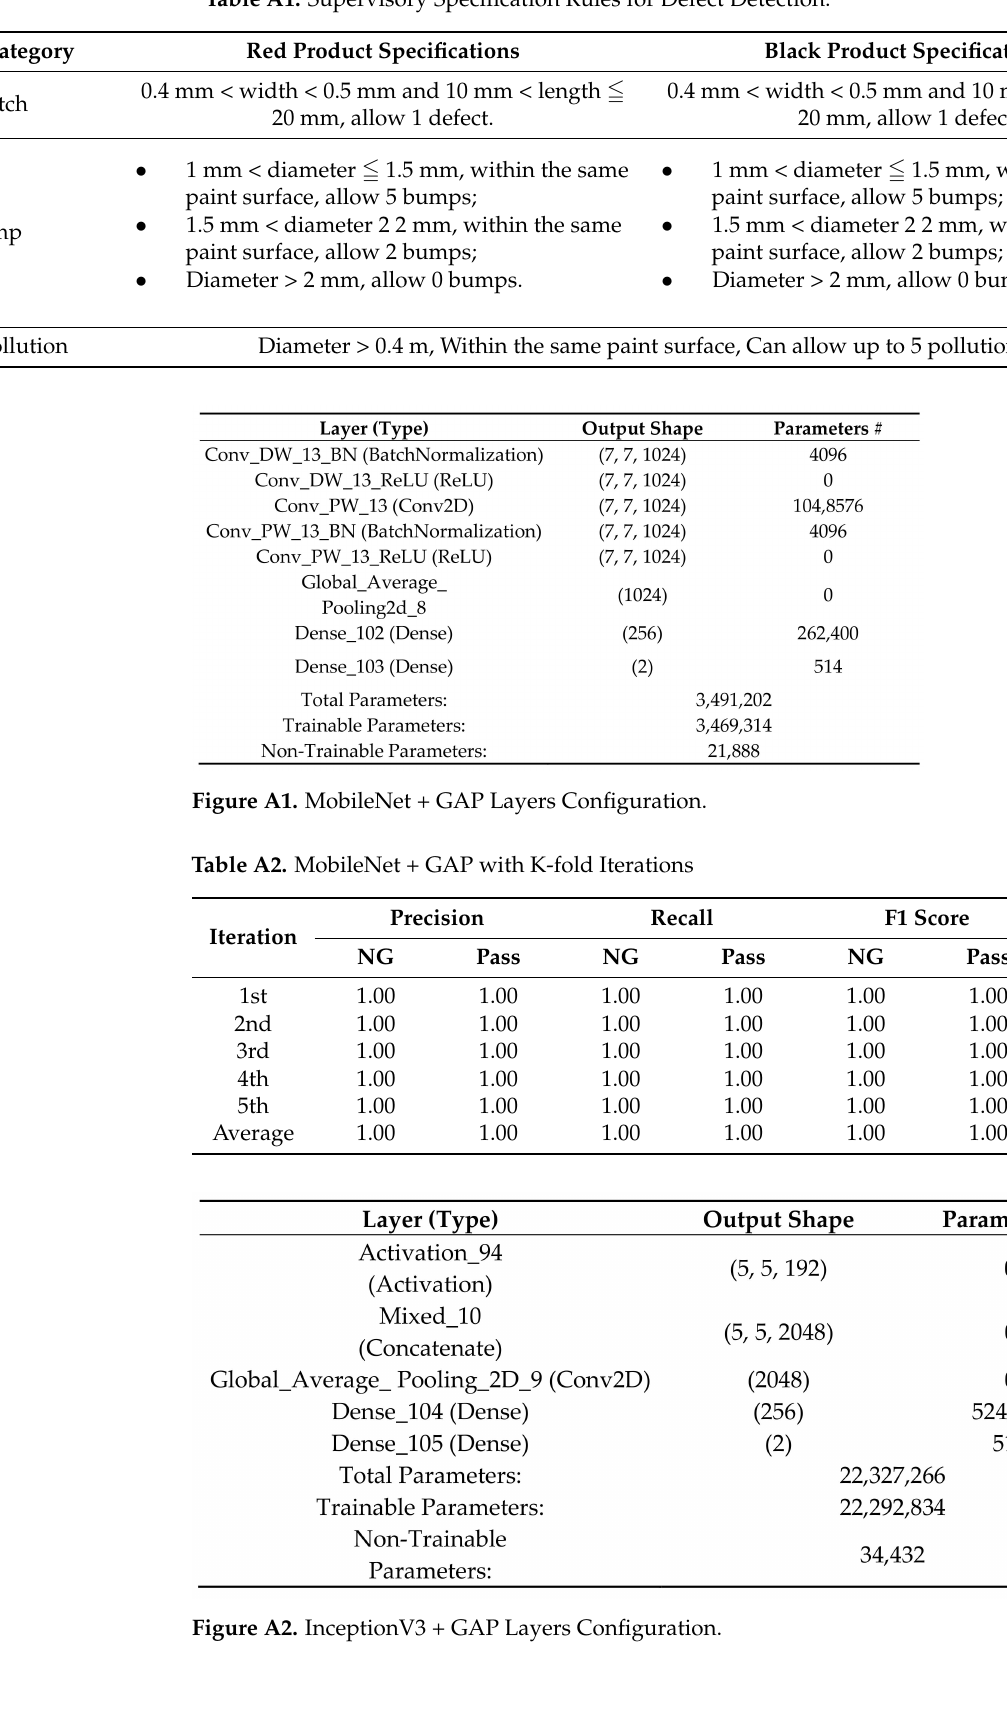
Table A1. Supervisory Specification Rules for Defect Detection.